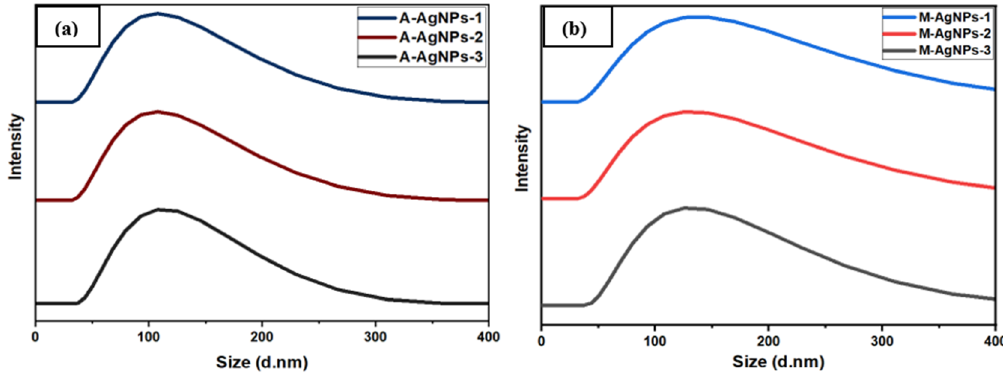
Figure 8. ( a , b ) Average size of A-AgNPs and M-AgNPs determined using DLS.